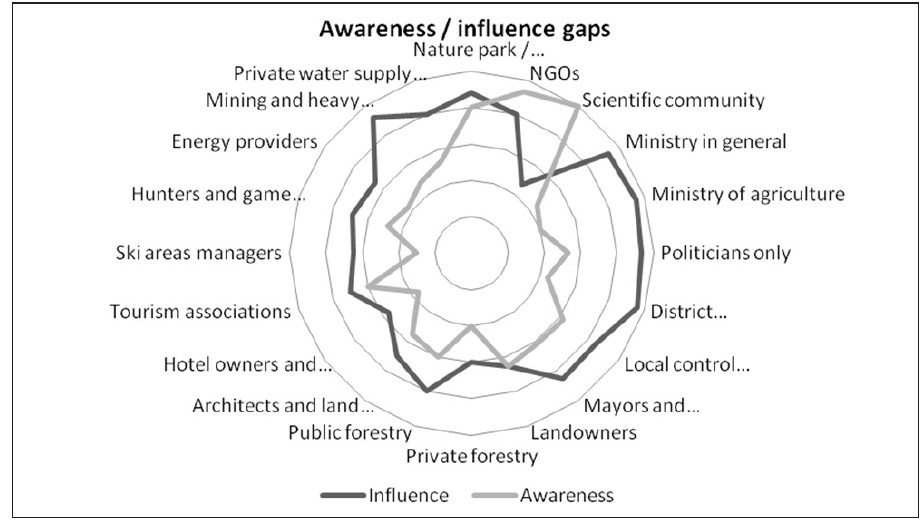
Figure 6. Awareness-influence